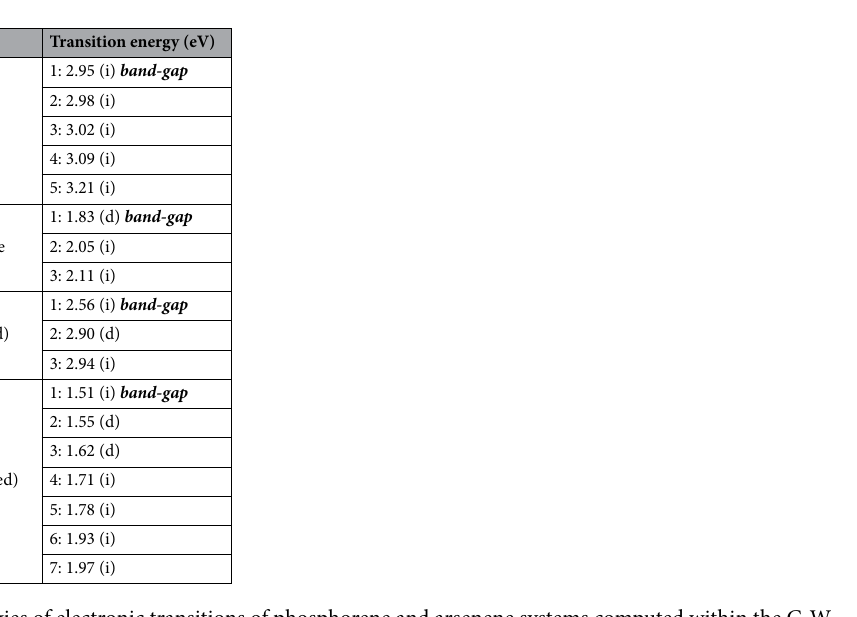
Figure 7. ( a ) Band structure; 1, 2, 3, 4, 5, 6 and 7 refers to possible electronic transitions. ( b ) projected density of states of puckered arsenene.